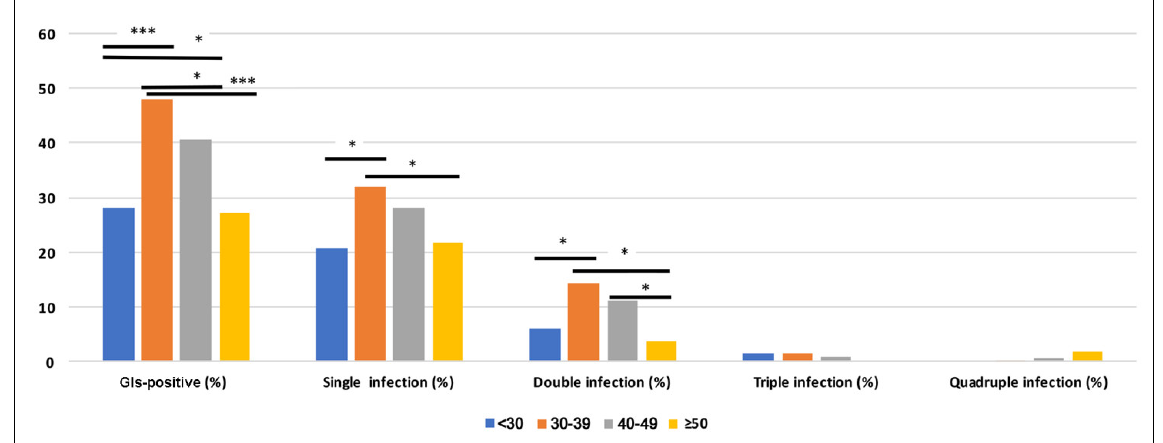
Figure 1. Distribution of GIs between age study groups. The statistical significance was calculated